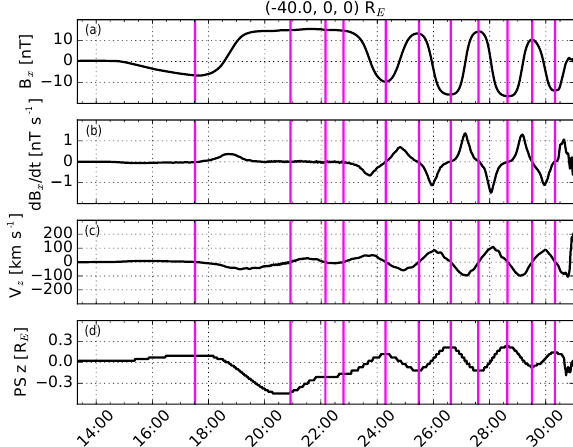
Figure 7. Time series observed by a virtual satellite located at x = − 40 R E and y = z = 0 in the simulation. From (a) to (d) , the parameters shown are earthward component of the magnetic field ( B x , cf. Fig. 2), time derivative of B x ( ∂B x /∂t , cf. Fig. 3), north component of the ion bulk flow ( V z , cf. Fig. 4), and location of the plasma sheet center in the z direction (PS z , cf. Fig. 5). The vertical magenta lines identify flapping half periods based on sign changes of V z , and they correspond to the magenta dots at x = − 40 R E in Fig.